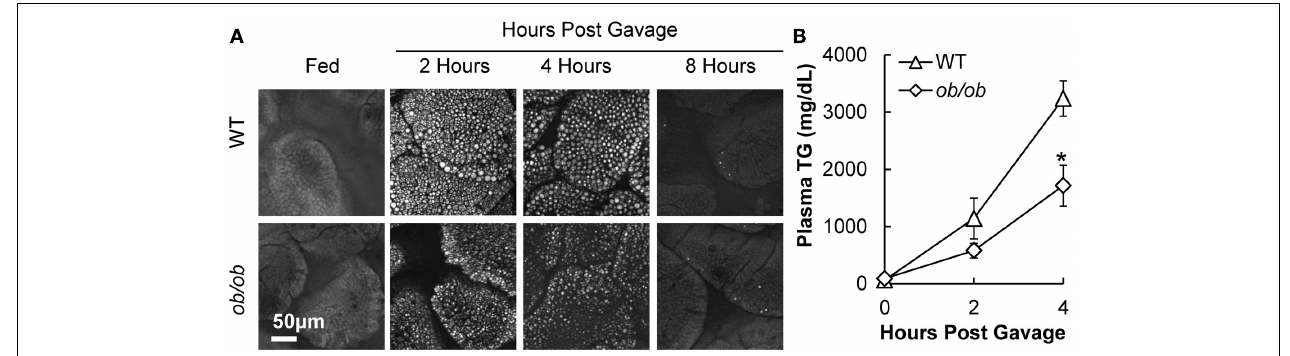
Tyloxapol into the intraperitoneal cavity to block lipase activity in circulation. After 30min, mice were administered 200 μ l olive oil via oral gavage and plasmaTG measured before and 2 and 4h post oil bolus. Data are represented as mean ± SEM. Asterisks denote significant differences between ob/ob and wild-type mice ( T- test), P < 0.05, n = 4–5